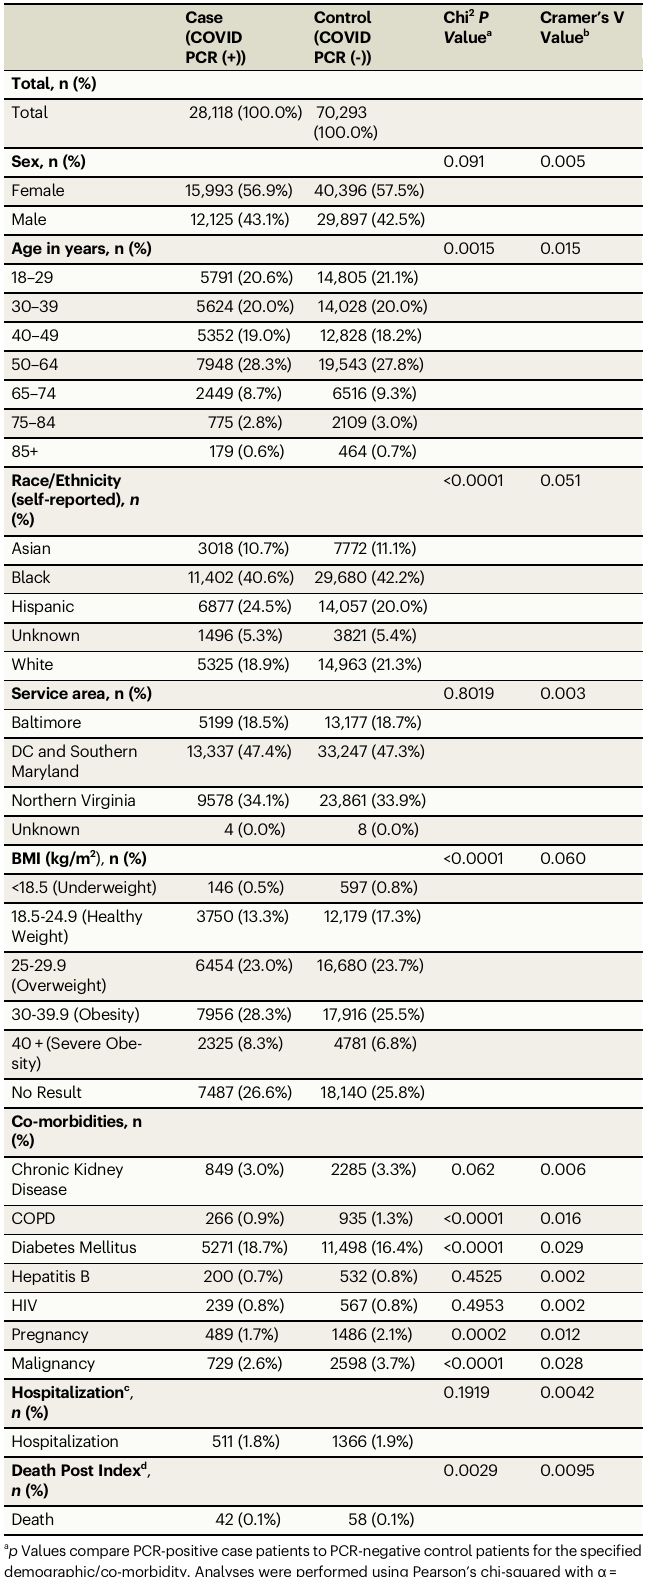
Table 3 | Patient demographics and co-morbidities for the matched